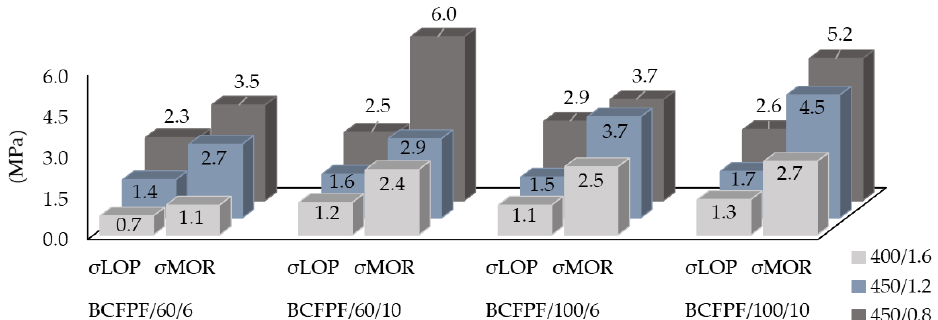
Figure 9. Graphs presenting a combination of σ LOP and σ MOR stress values for fiber-reinforced soil- cements with the addition of BCFPF (bundles of coiled fibrillated-tapes polypropylene fibers).